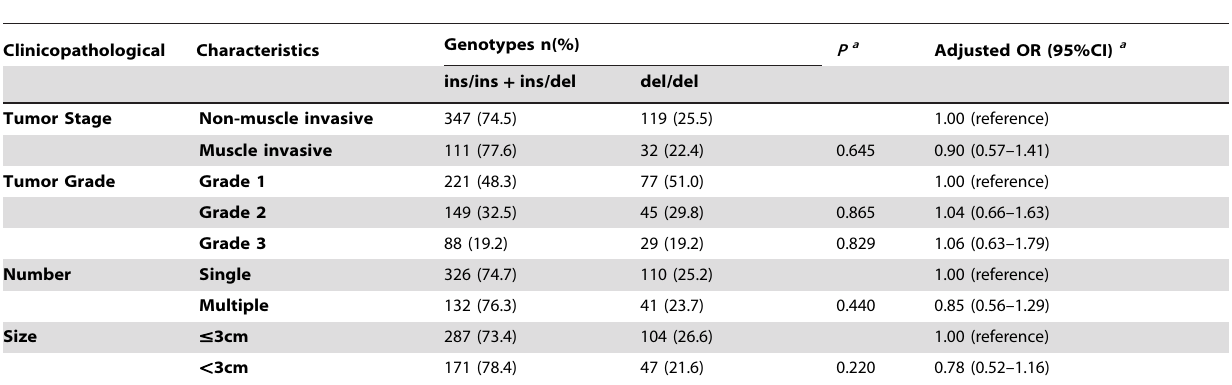
Table 5. NFKB1 promoter –94 ins/del ATTG polymorphism and clinicopathological characteristics in patients with bladder